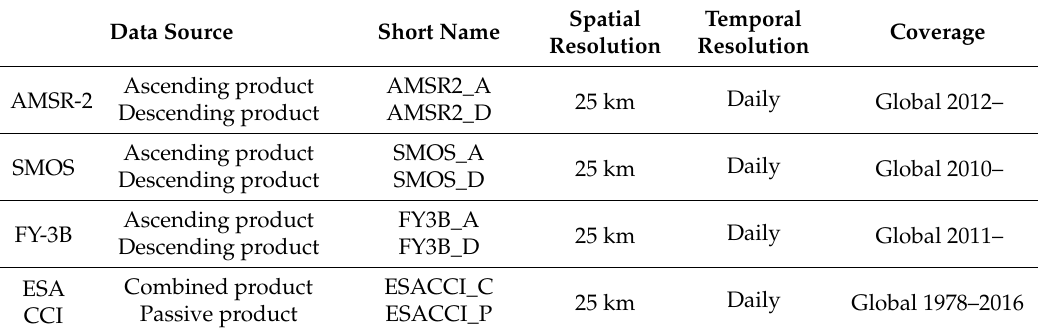
Table 1. Summary of the satellite based SSM